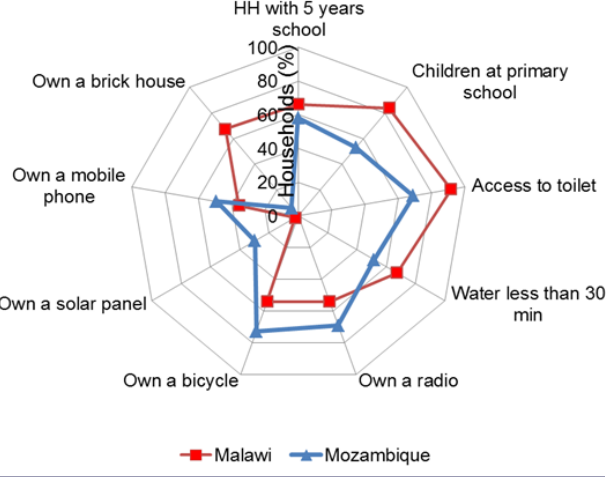
Fig. 5 . Multidimensional poverty indicators for farmers in Malawi and Mozambique (% of